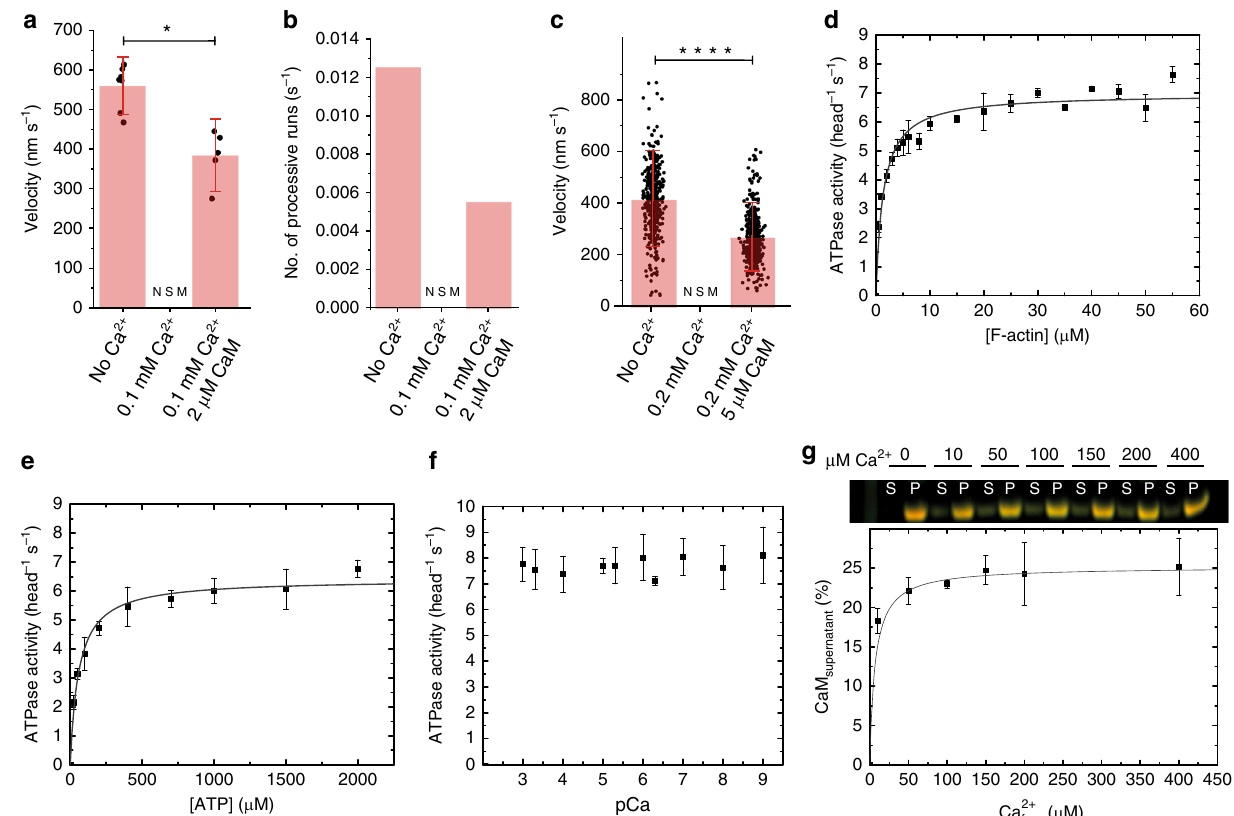
Fig. 6 Effect of Ca 2 + and CaM on single-molecule processivity and ensemble kinetics of myosin-5B. Dependence of myosin-5B velocity ( a ) and number of processive runs ( b ) on Ca 2 + and CaM in the single-molecule motility assay. In this particular set of measurements, we observed 0.0125 runs s − 1 with an average velocity of 559 ± 64 nm s − 1 in the absence of Ca 2 + and CaM. In the presence of 0.1 mM Ca 2 + , no signi fi cant movement (NSM) was observed. In the presence of 0.1 mM Ca 2 + and 2 μ M CaM, myosin processivity and velocity were partially rescued to 0.0055 runs s − 1 and 383 ± 93 nm s − 1 at [ATP] = 1000 μ M ( n = 12, p value = 0.02). Error bars, s.d. No error bars are reported in b because data are from single experiments. c Dependence of myosin-5B velocity on Ca 2 + and CaM in the gliding assay. Myosin-5B translocated actin fi laments with a speed of 413 ± 128 nm s − 1 ( n = 417) in the in vitro gliding assay. Filaments movement stalled (NSM) in the presence of 0.2 mM Ca 2 + but was partially restored (264 ± 92 nm s − 1 , n = 439, p value = 4E − 17) in the presence of 5 µ M CaM. Error bars, s.d. Student ’ s t test applied on a and c , * P < 0.1, **** P < 0.0001. d Actin-activated steady-state ATPase activity of myosin-5B yielding the kinetic parameters k cat = 6.96 ± 0.14 s − 1 and K app = 1.34 ± 0.16 µ M ( n = 3). e ATP-dependence of the steady-state ATPase activity of myosin-5B at 30 µ M [F-actin] ( k cat,ATP = 6.41 ± 0.14 s − 1 ; K app,ATP = 59.07 ± 6.95 µ M) ( n = 3). f Increasing [Ca 2 + ] does not affect the steady state show that increasing concentrations of Ca 2 + partially dissociate CaM from myosin-5B. The abbreviations S and P refer to supernatant and pellet fraction (full-length gel image in Supplementary Fig. 6). Bottom, densitometric analysis shows that on average 25% of the six CaM molecules dissociate with a K D < 10 µ M Ca 2 + per myosin-5B heavy chain ( n